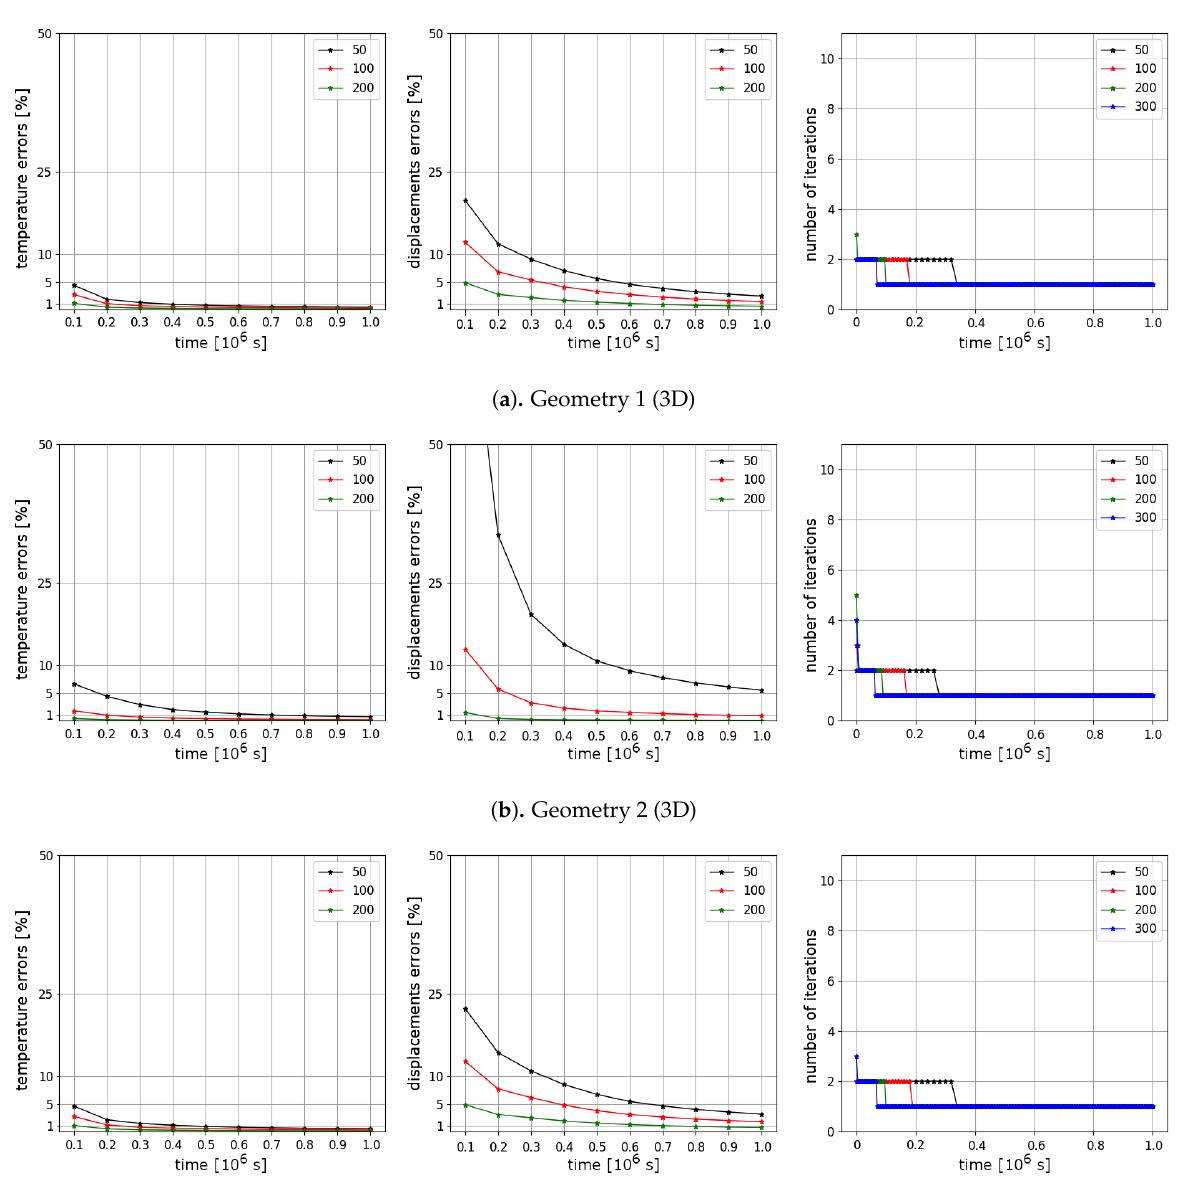
Figure 14. Test 1 for a three-dimensional problem. Results for a solution using Picard iterations with different number of time steps t m , m = 50,100, 200. Relative errors in % for temperature and displacements for 10 time layers (first and second columns). Number of Picard iterations by time (third